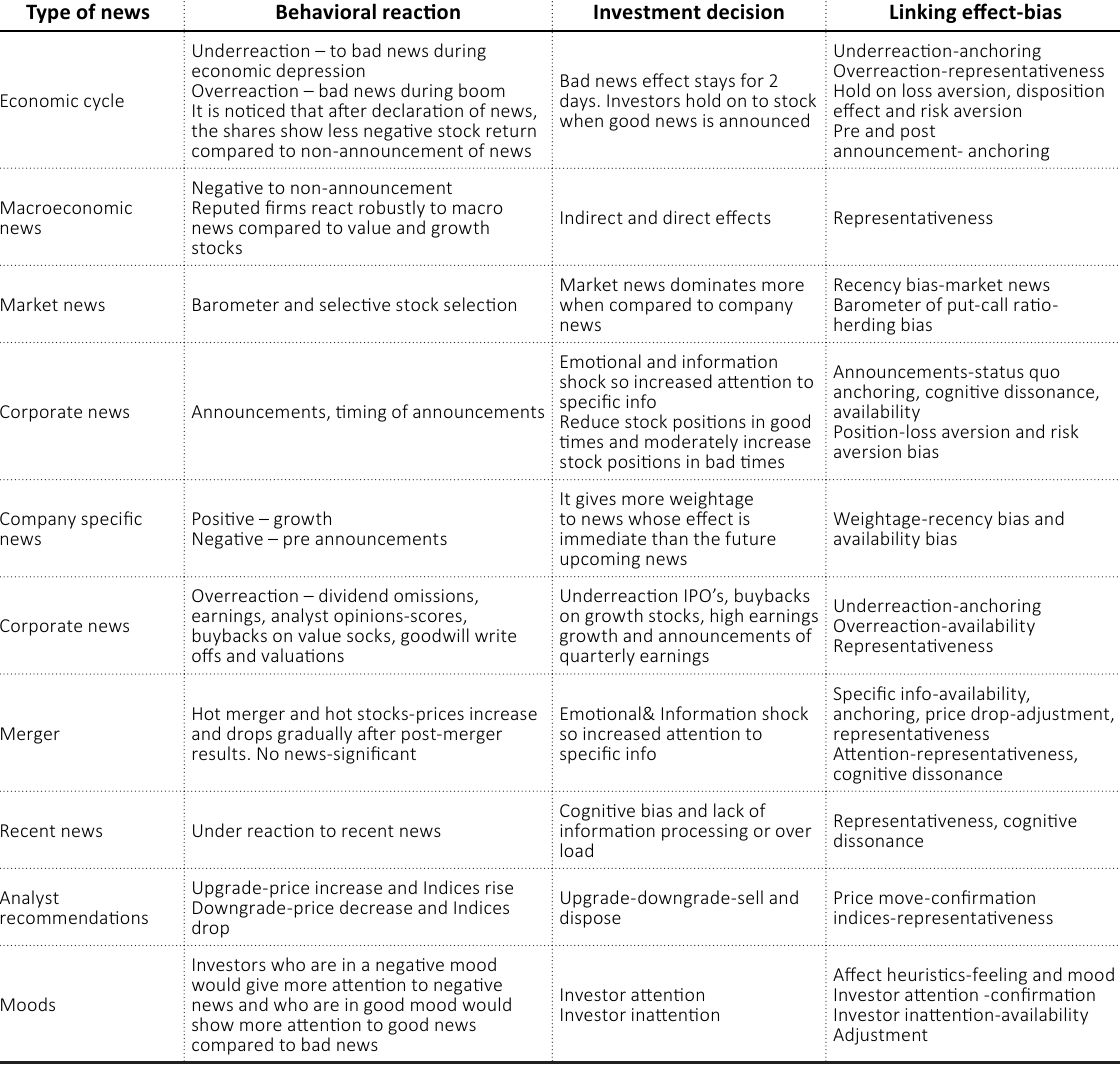
Table 1. Influence of different type of news on individual investor’s decision making in stock markets and its linking effect on behavioral theories and